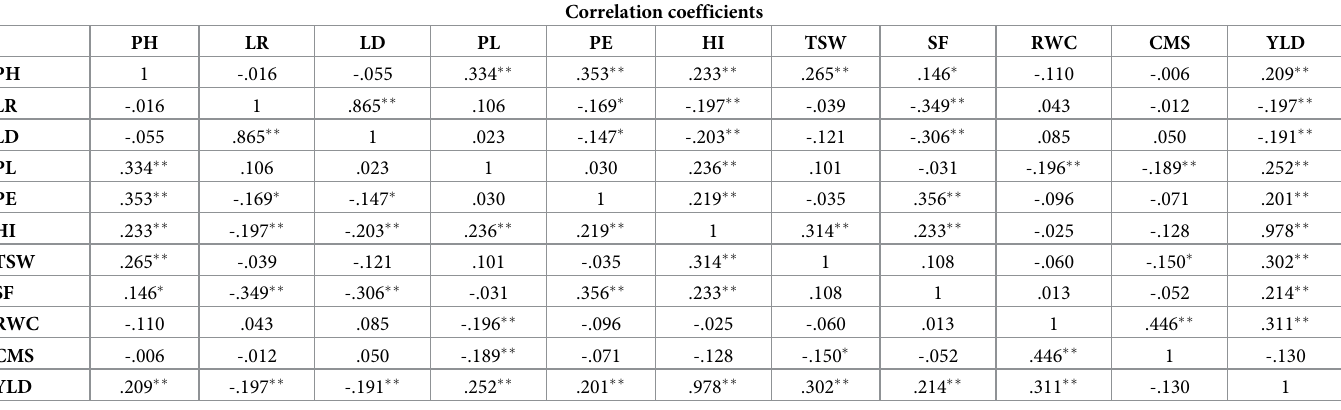
Table 5. Correlation coefficients of morpho-physiological traits among themselves and with grain yield under reproductive stage drought